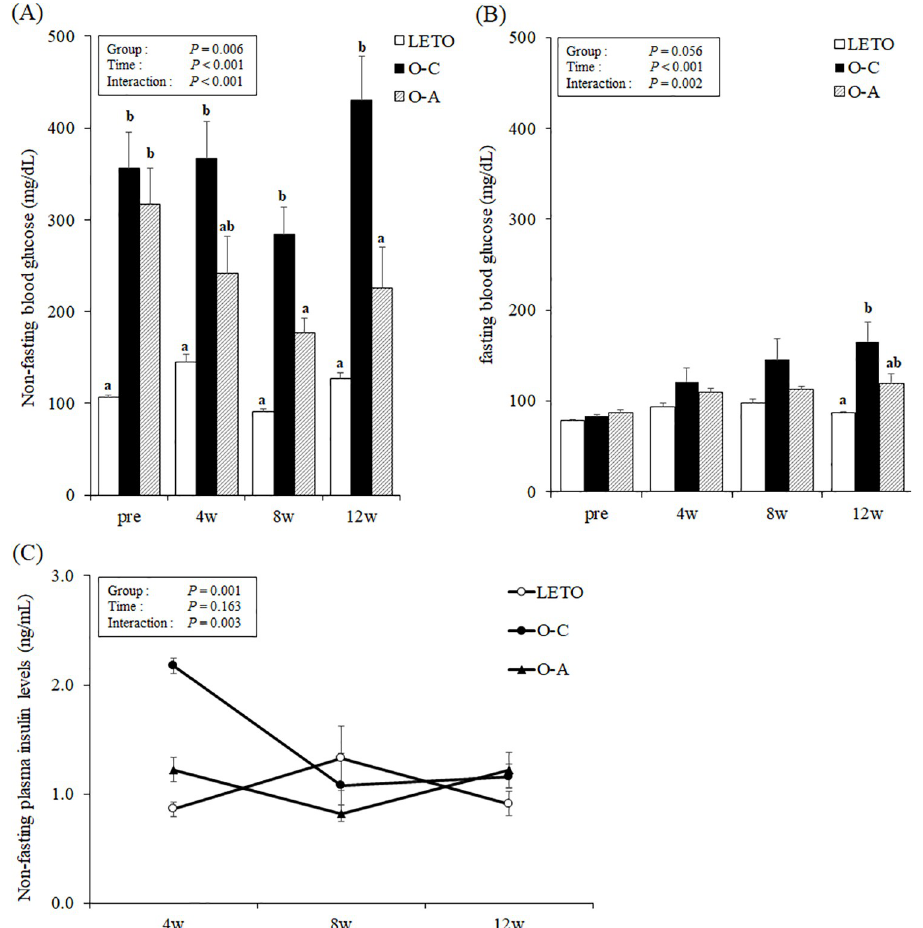
Fig 1. Periodic changes in the biochemical parameters relating glucose metabolism in OLETF and LETO rats. (A) Non-fasting blood glucose. (B) Fasting blood glucose. (C) Non-fasting insulin levels. The data are presented as mean ± standard error (SE) (n = 10 for OLETF rats and n = 6 for LETO rats). The overall P value from the two-way repeated measures ANOVA with repeated measures is shown in the graph. ab Different letters in the same column indicate statistical difference, P < 0.05, Tukey’s multiple comparison test. LETO, Long-Evans Tokushima Otsuka; OLETF, Otsuka Long-Evans Tokushima fatty; O-C, OLETF control; O-A, OLETF D -allulose.